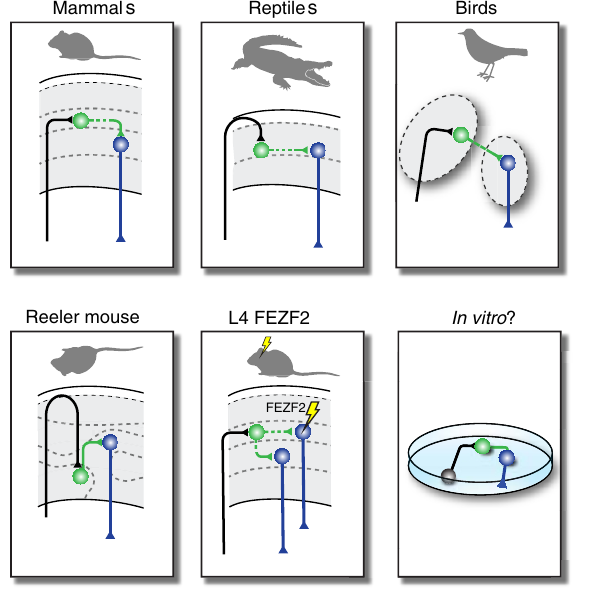
Figure 4 | Self-organizing properties of neocortical neurons. The assembly of neurons into circuits may to some extent be independent of the spatial relationships between these neurons, due to the existence of conserved, location-independent molecular controls. Input neurons (in black) connect to intracortically projecting neurons (in green), which project to output neurons (in blue). A current limitation in testing this hypothesis is our generally limited ability to establish unambiguous correspondences in cell types across species/conditions. Reeler mouse, see ref. 74; L4 FEZF2 overexpression, see ref.